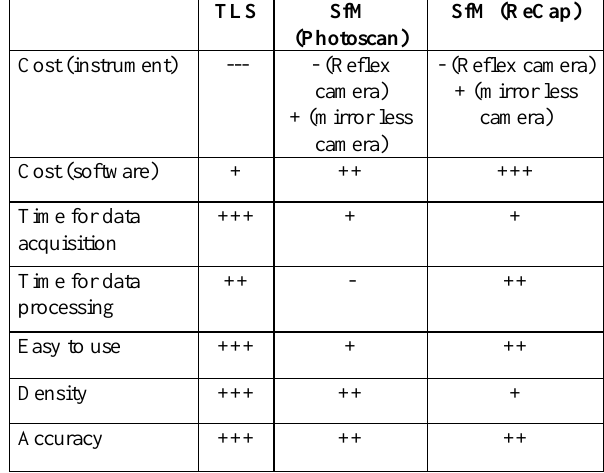
Table 1. Comparison of the used methods and